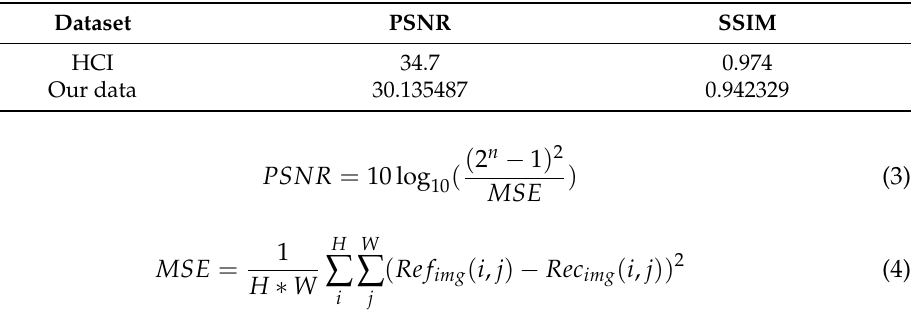
Table 3. Results comparision between HCI dataset and our dataset.